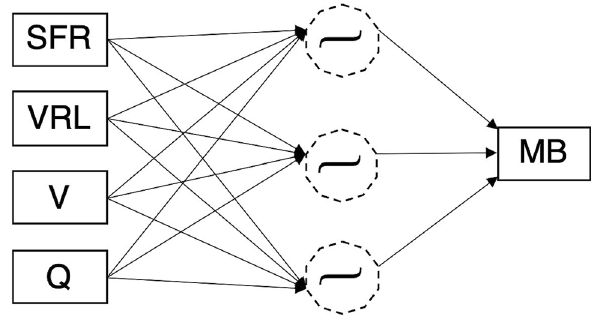
Figure 2. Structure of the neural network model used for the estimation of the number of microbubbles delivered from a venous reservoir.